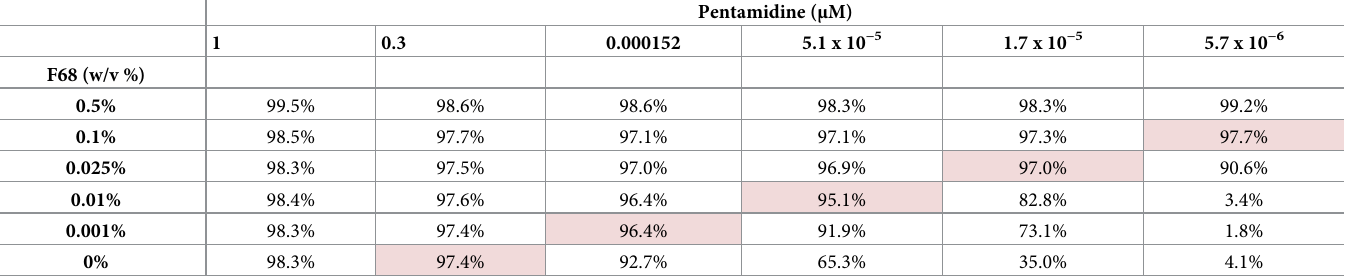
To determine if the addition of Pluronic to pentamidine had an additive effect on the trypa- nocidal activity of pentamidine, it was decided that work should focus on F68 rather than the other Pluronics, as both P85 and P105 caused an inhibitory effect on insulin secretion. Although IC values could only be determined for two combinations, in part due to the high 50 starting concentration of pentamidine used, a limited interaction between Pluronic F68 and Table 8. The % of bsf trypomastigotes inhibited by pentamidine/pluronic combinations. The combination formulation was tested in triplicate and repeated in 3 sepa- rate experiments (n = 3). Pentamidine ( μ